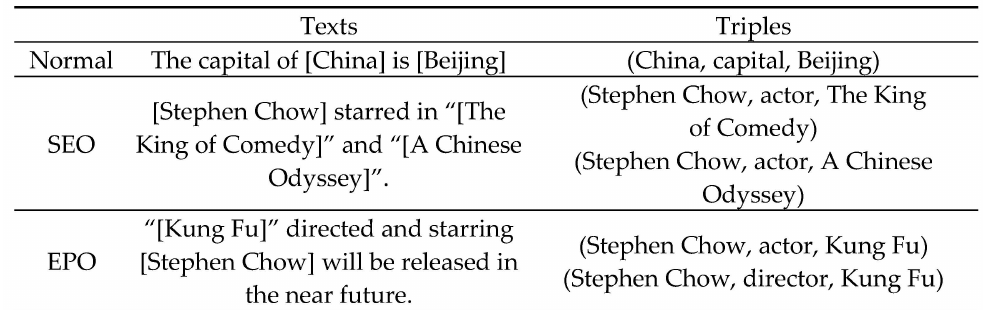
Figure 1. Examples of overlapping triples are divided into normal, single entity overlap (SEO), and entity pair overlap